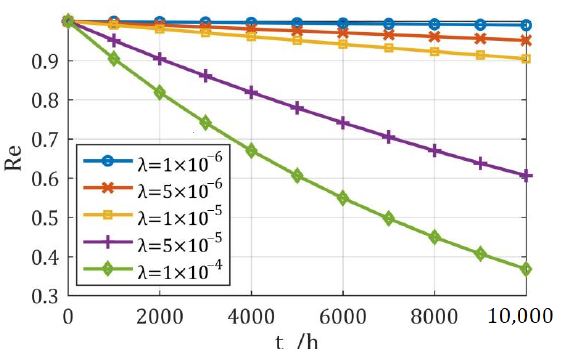
Figure 7. Reliability variations of a FMS before and after the element maintenance over the main- tenance parameters. ( a ) Variations over the maintenance period. ( b ) Variations over the mainte- nance coefficient.